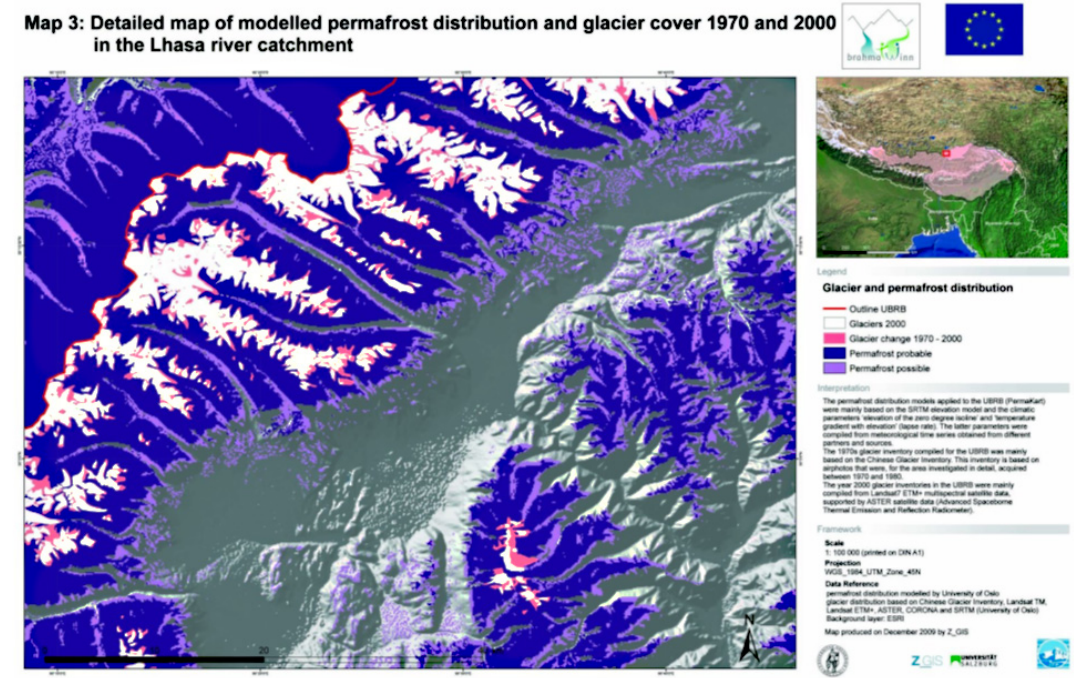
Figure 2. Glacier change and permafrost distribution for a reference site in the Lhasa catchment.